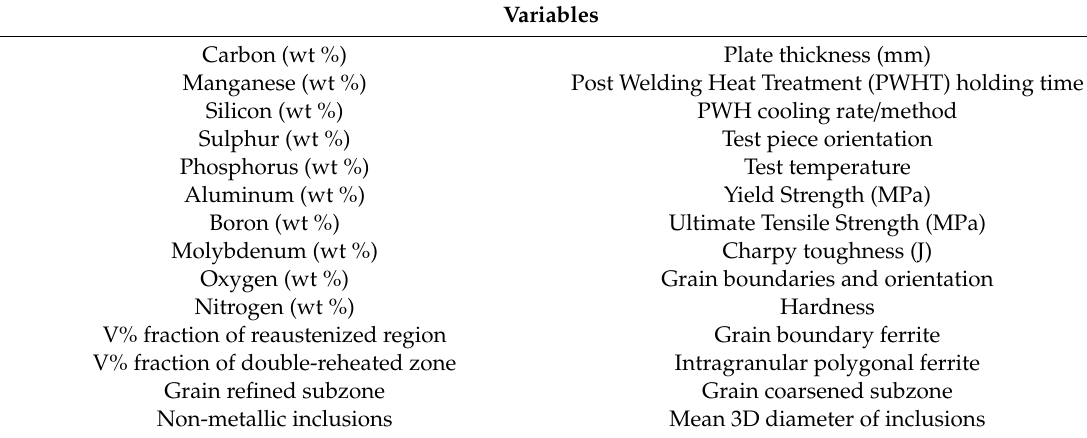
Table 1. Non-exhaustive selection of variables with proven influence on material properties.